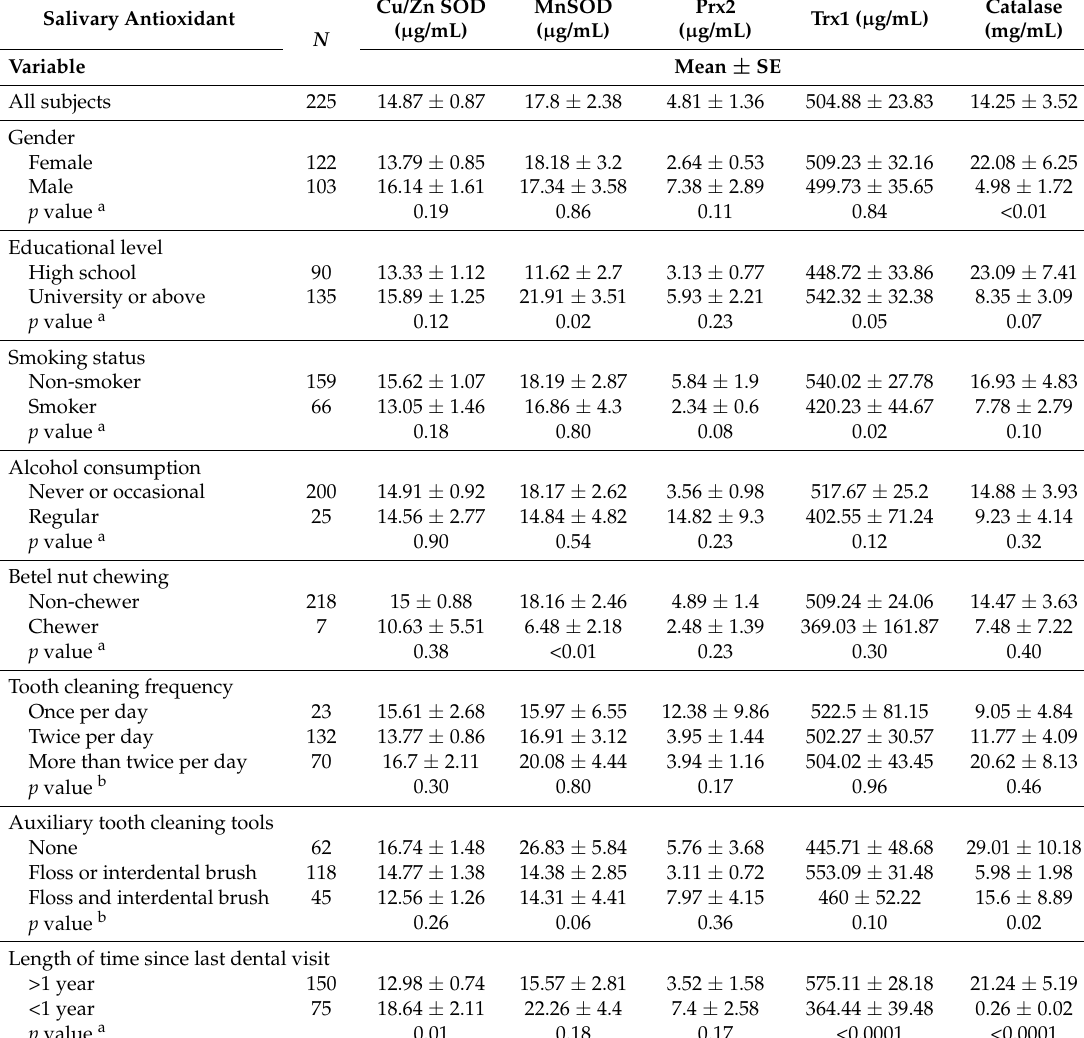
Table 2. Demographic characteristics, oral health behaviors, and distributions of salivary